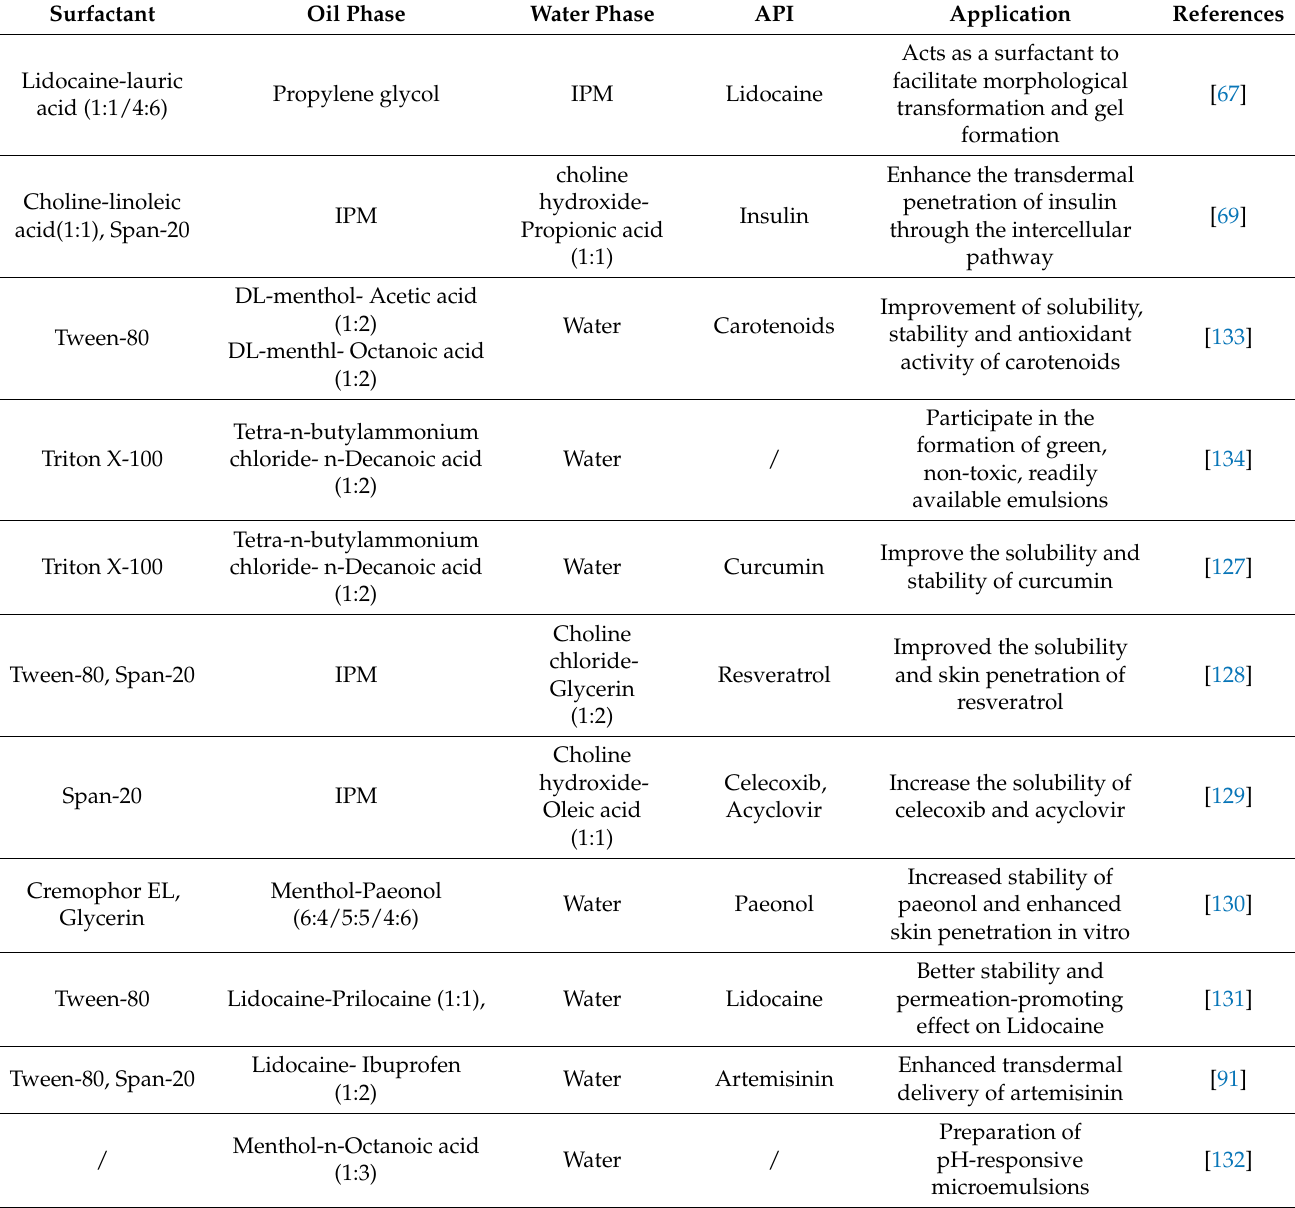
Table 4. Preparations of DES-microemulsions and their